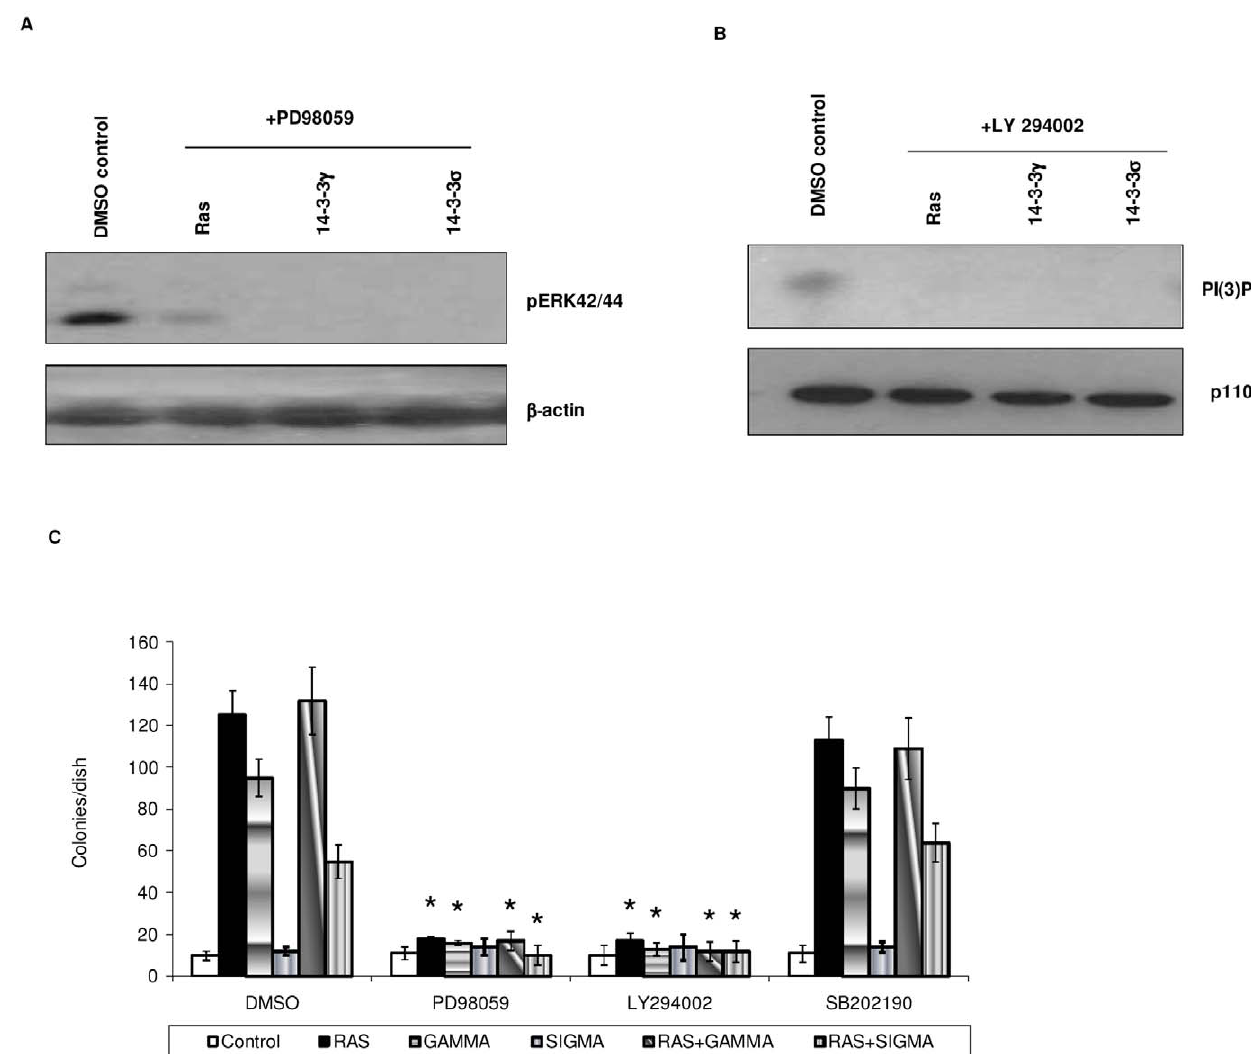
Figure 3. Transformation by 14-3-3 c requires active MAPK and PI3Kinase pathways. NIH3T3 cells were transfected with H-ras, 14-3-3 c , or 14-3-3 s plasmids and incubated for 48 hours in DMEM medium containing either 15 m M PD98059 or 5 m M LY294002. DMEM supplemented with DMSO served as a control. After 48 h, the cells were harvested and extracts prepared and examined for the presence of phosphorylated ERK42/44 by immunoblotting (A) or tested for PI3K activity (B) as described in the methods section. These experiments were repeated twice. A representative figure is shown. (C) NIH3T3 focus formation assays were conducted as in figure 1 using either H-ras, 14-3-3 c , 14-3-3 s , or a combination of H-ras plus 14-3-3 c or 14-3-3 s and in media with or without 15 m M PD98059, 5 m M LY294002 or 1 m M SB202190. The assays were maintained in an incubator at 37 u C and 5% CO 2 for 21 days and the colonies stained and counted. The bars represent the average number of colonies per 100 mm dish from two independent experiments. Error bars depict standard deviation. (*, p , 0.05, Student’s t-test, compared with control assay conducted in the absence of inhibitor). found that raf-1 co-immunoprecipitated with 14-3-3 c , but not 14-